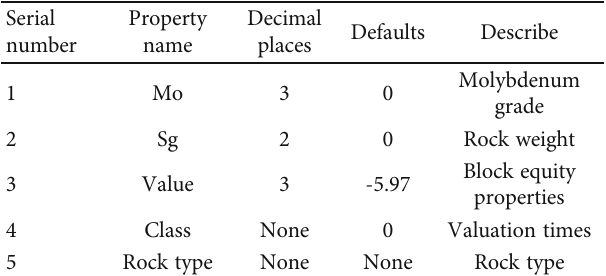
Table 6: Model property